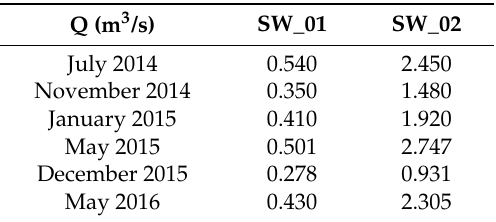
Table 2. Mean discharge values obtained by current-meter method, upstream (SW_01) and downstream (SW_02) the Pertuso Spring.